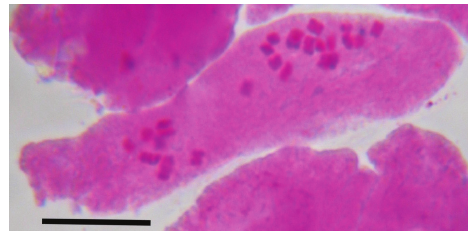
Figure 8. Taraxacum gianninii Arrigoni, Ferretti & Padula, 2 n = 24. Scale bar: 10 μm.